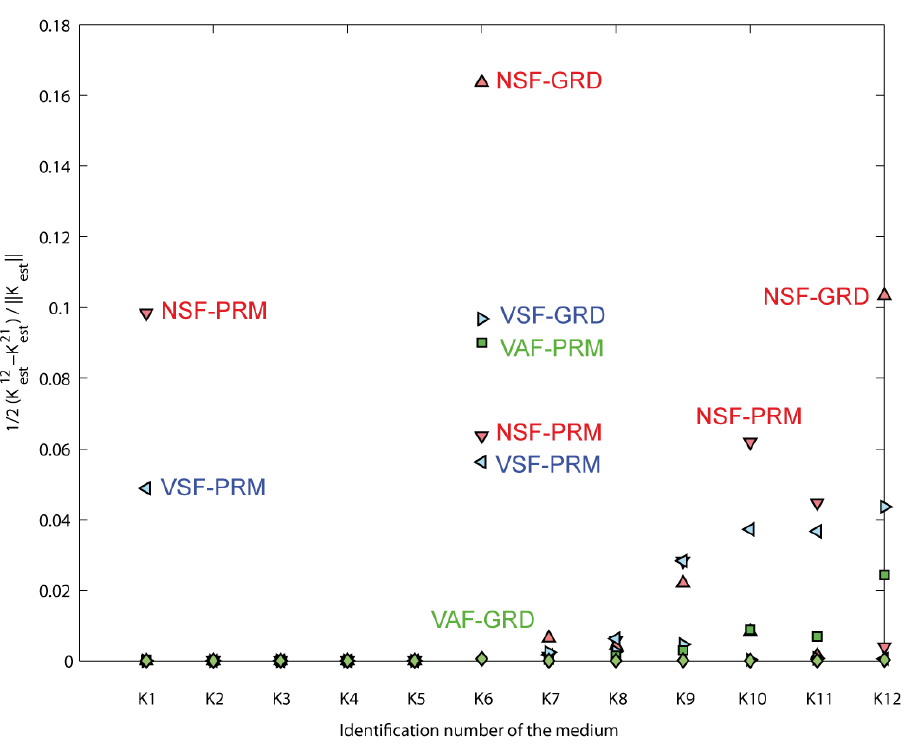
Figure 17. Magnitude 𝛽 of the antisymmetric component of the equivalent permeability tensors, relative to the Frobenius norm of the full permeability tensor.